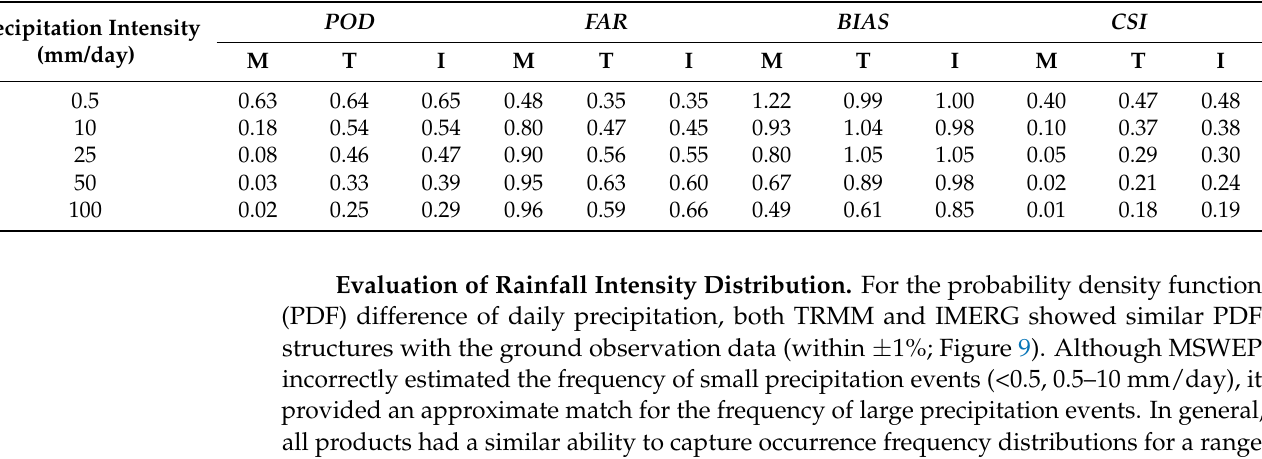
Table 3. The detection capacities of rainfall at different magnitudes. The POD , FAR , BIAS , and CSI contingency statistics obtained using various precipitation thresholds (0.5, 10, 25, 50, 100 mm/day) of daily observed precipitation over the Min Jiang watershed. M, T, and I represent the MSWEP, TRMM, and IMERG products, respectively. Precipitation